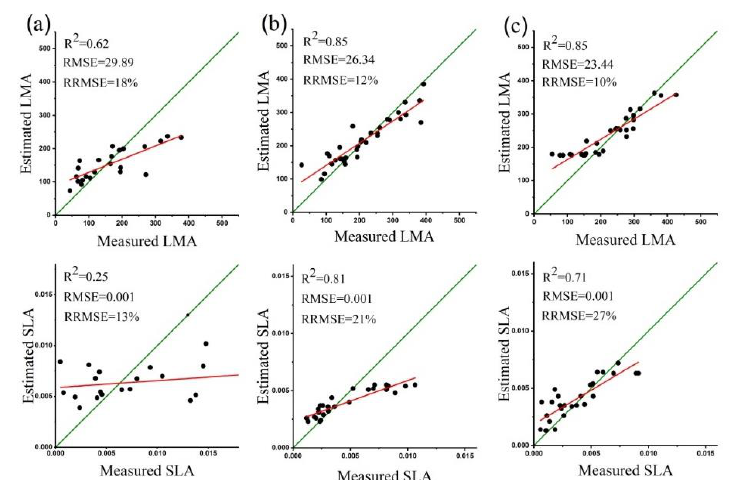
Figure 5. Estimated vs. measured LAI at the flowering stage. The green line shows the 1:1 correlation of the estimated and measured variables, whereas the red lines represent the linear regression models.